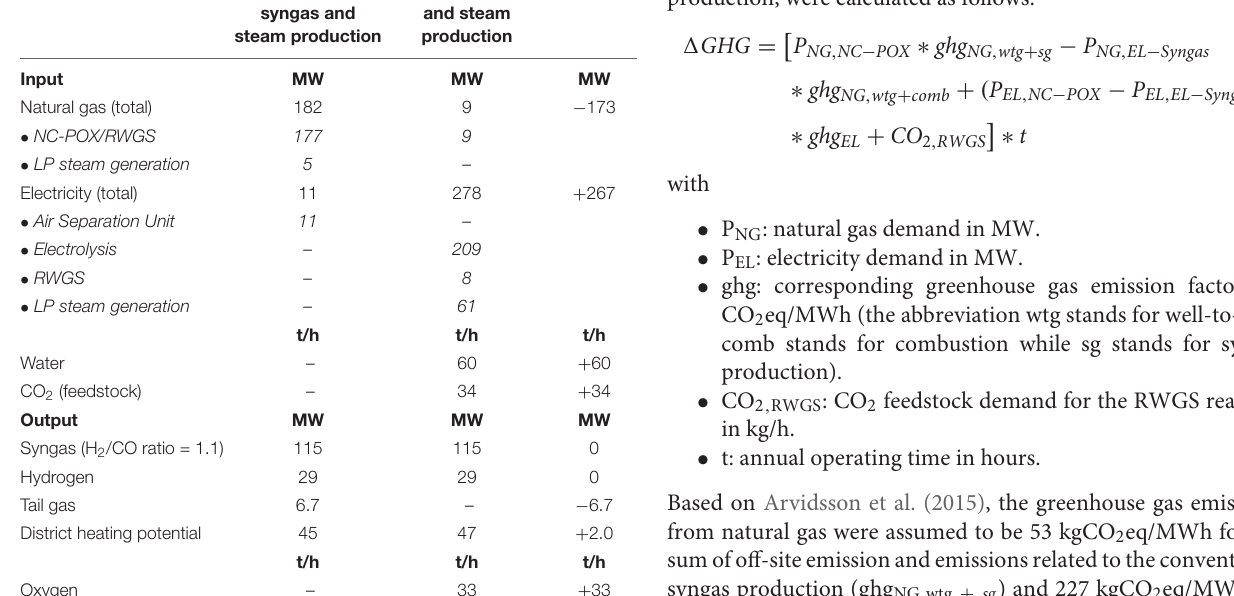
Variable Conventional